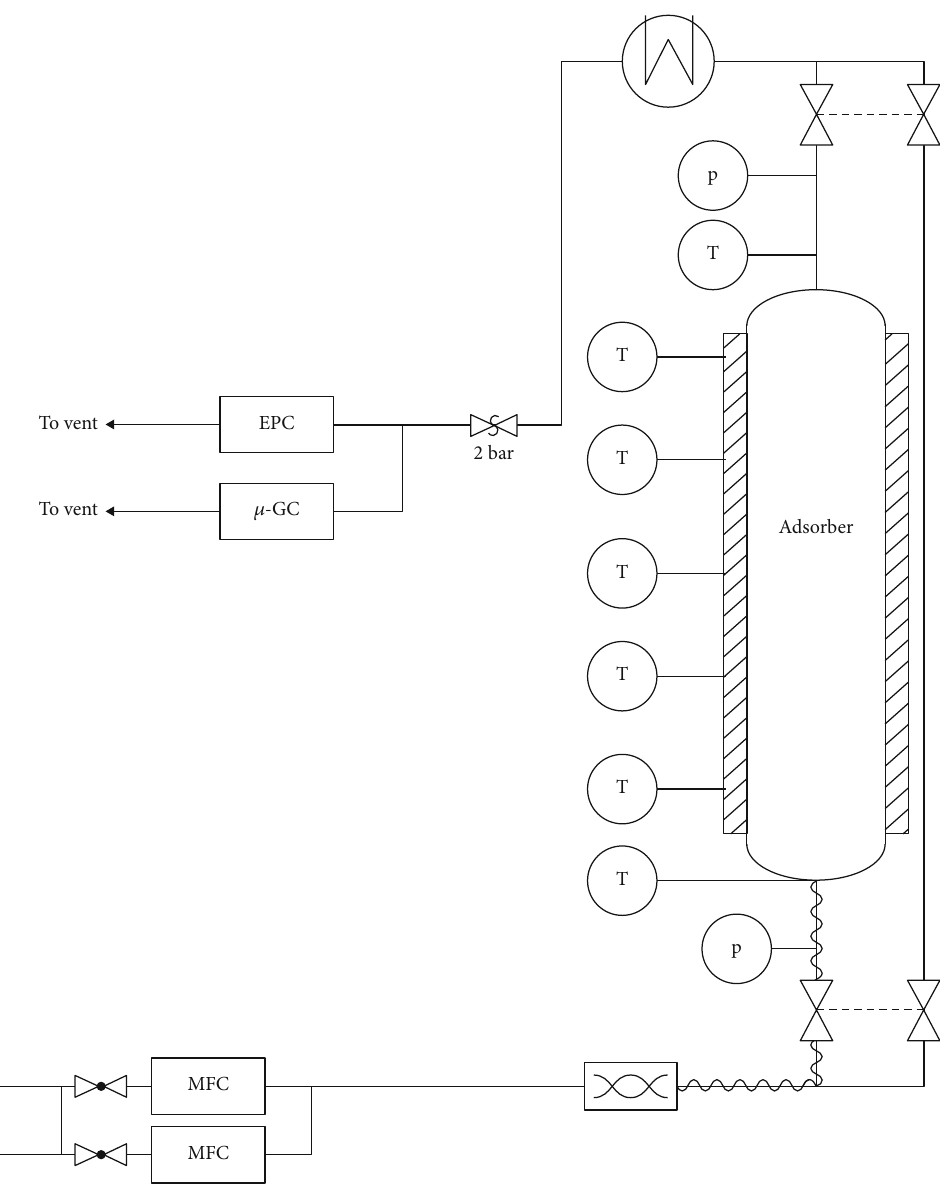
Figure 3: Flow diagram of the experimental adsorber plant ( “ T ” marks the position of the thermocouple type T, and “ p ” marks the position of the pressure